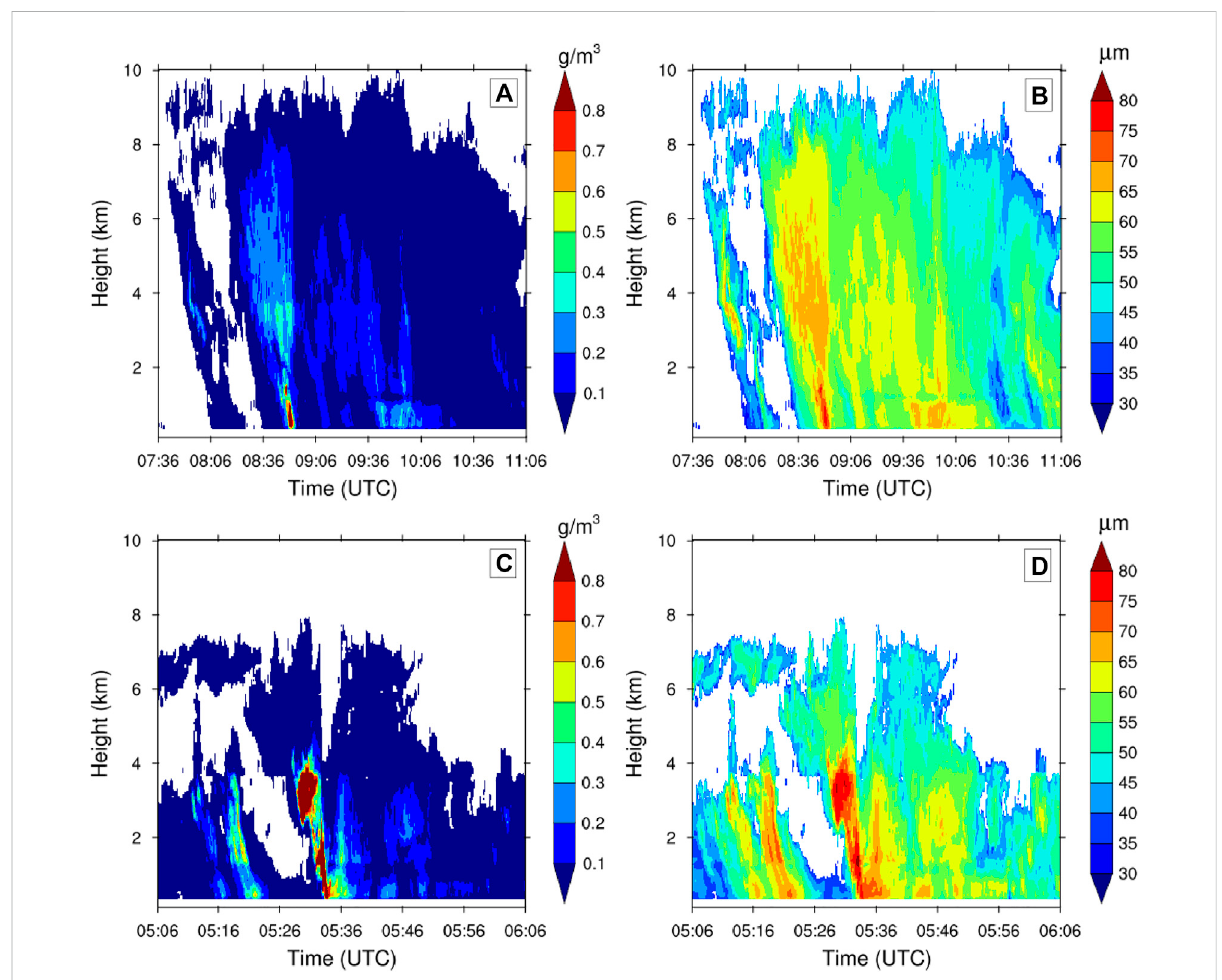
FIGURE 7 TimeseriesoftheverticaldistributionoficewatercontentandparticleequivalentradiusinPVthunderstorm (A,B) andinTCthunderstorm (C,D) .